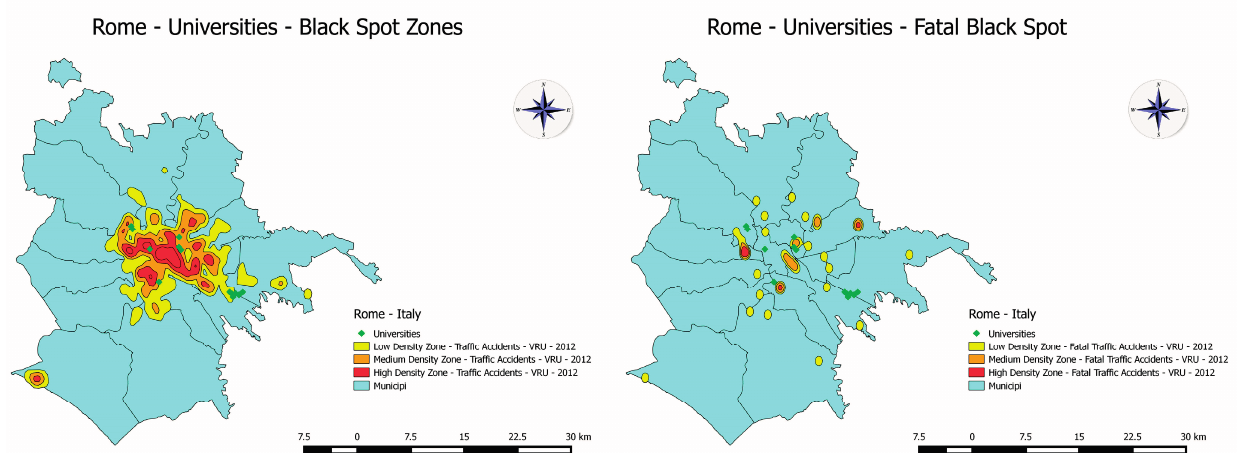
Figure 13. Universities and colleges/black spots: